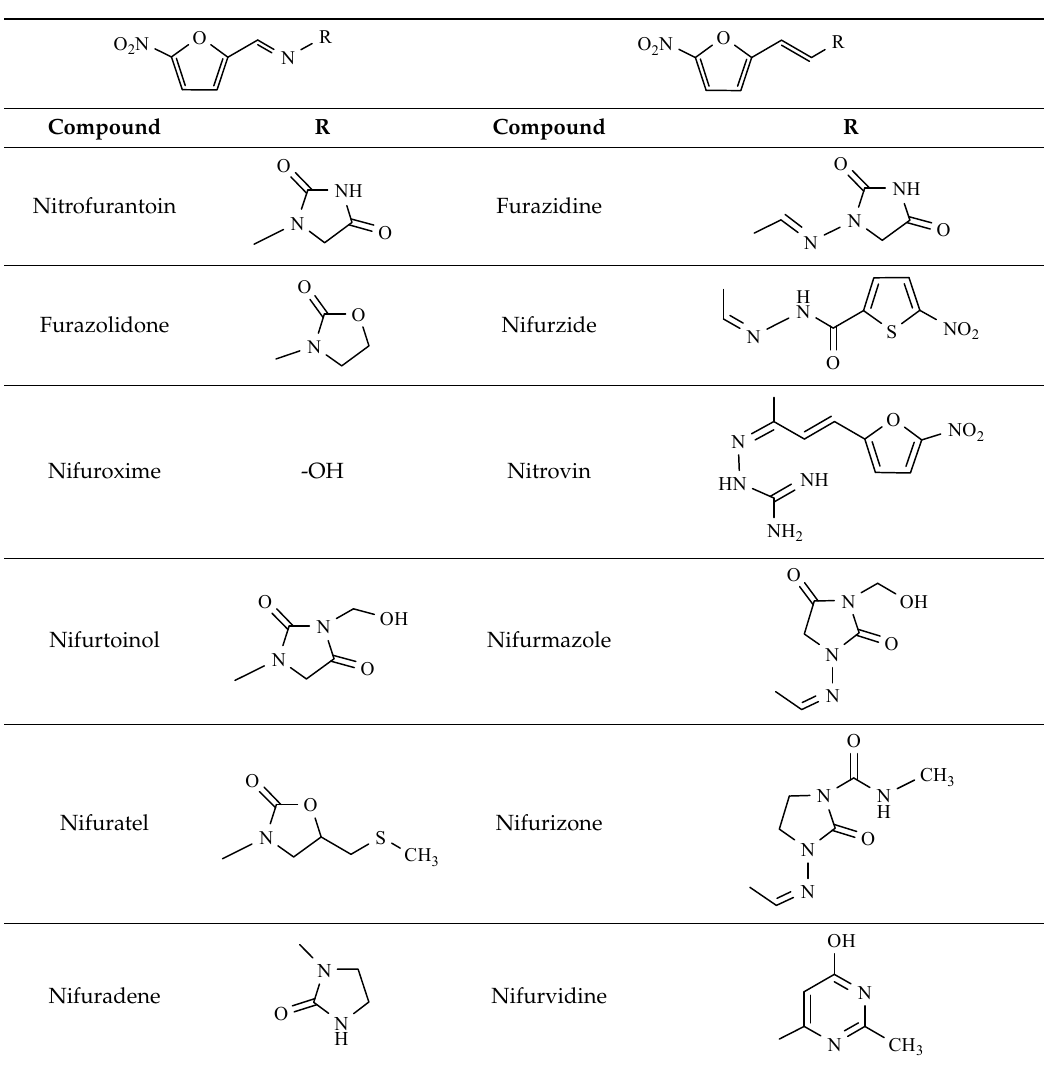
Table 2. 5-Nitrofuran analogues with antibacterial